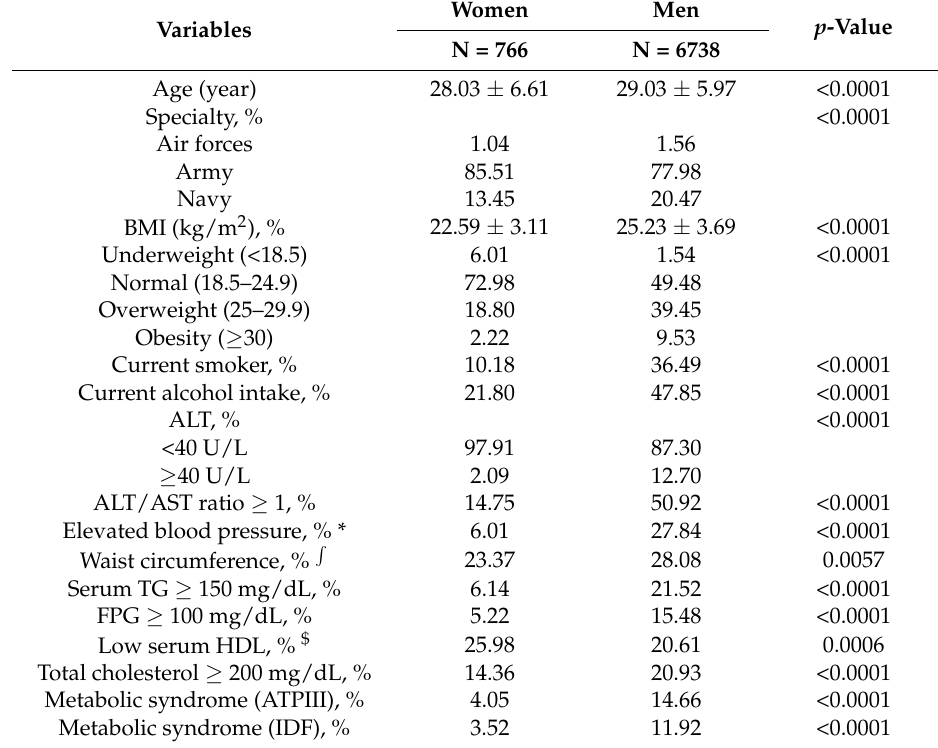
Table 2. Baseline characteristics of the study cohort of men and